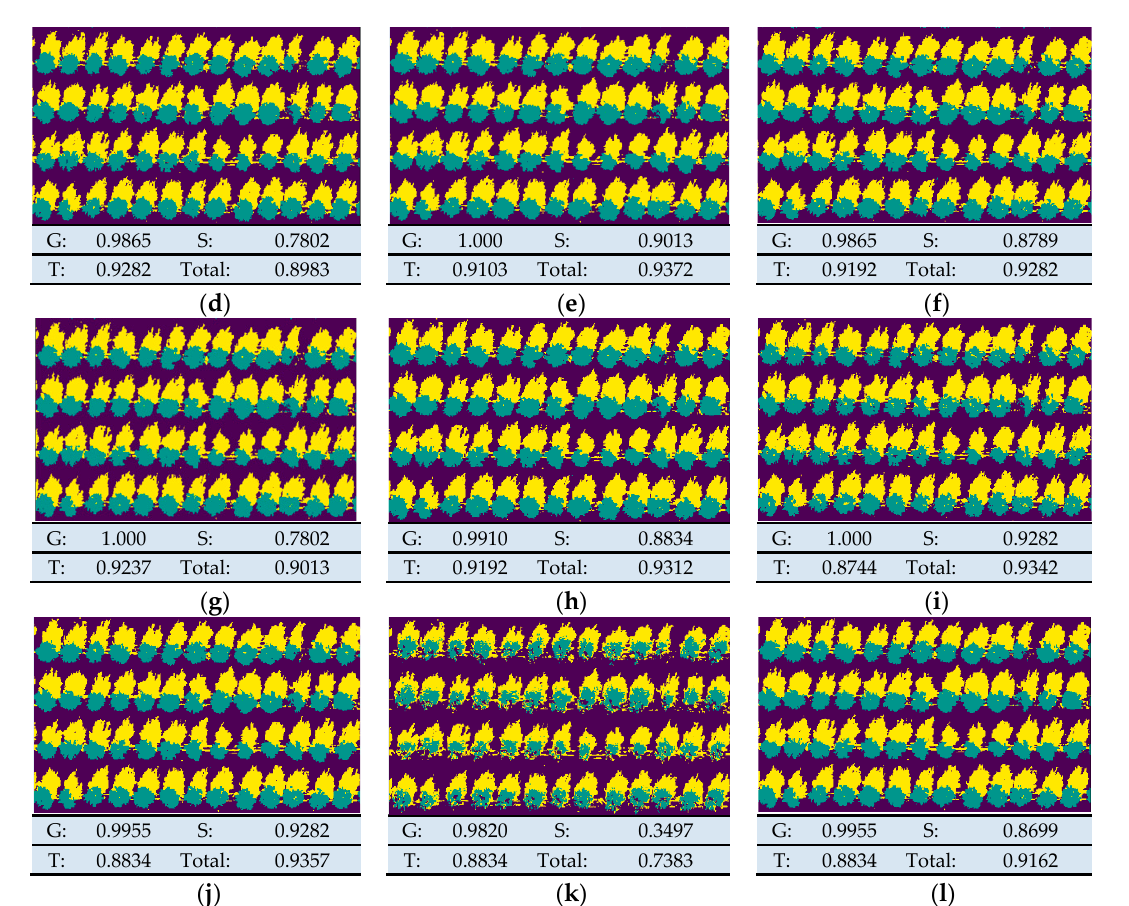
Figure 6. Schematic diagram of classification effect under different vegetation indices. G, T, and S represent the classification accuracy of ground, tree, and shadow, respectively, and T represents the total recognition accuracy. The image is classified using different VI indices. ( a ): Reference; ( b ): Green_ Index; ( c ): SR_ Index; ( d ): SRB_ Index; ( e ): NDVI_ Index; ( f ): NDRE_